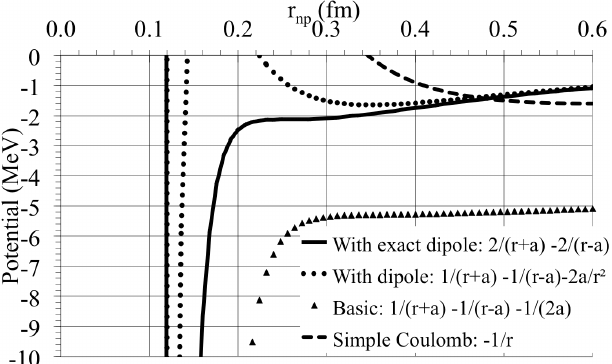
Figure 2: Calculated deuteron electromagnetic potential. - Four electrostatic approximations have been tested, the magnetic repulsion being standard. From top to bottom: exact dipole formula doubled, Coulomb plus dipole for- mula, basic Coulomb for three interacting charges and sim- ple Coulomb neglecting the positive charge of the